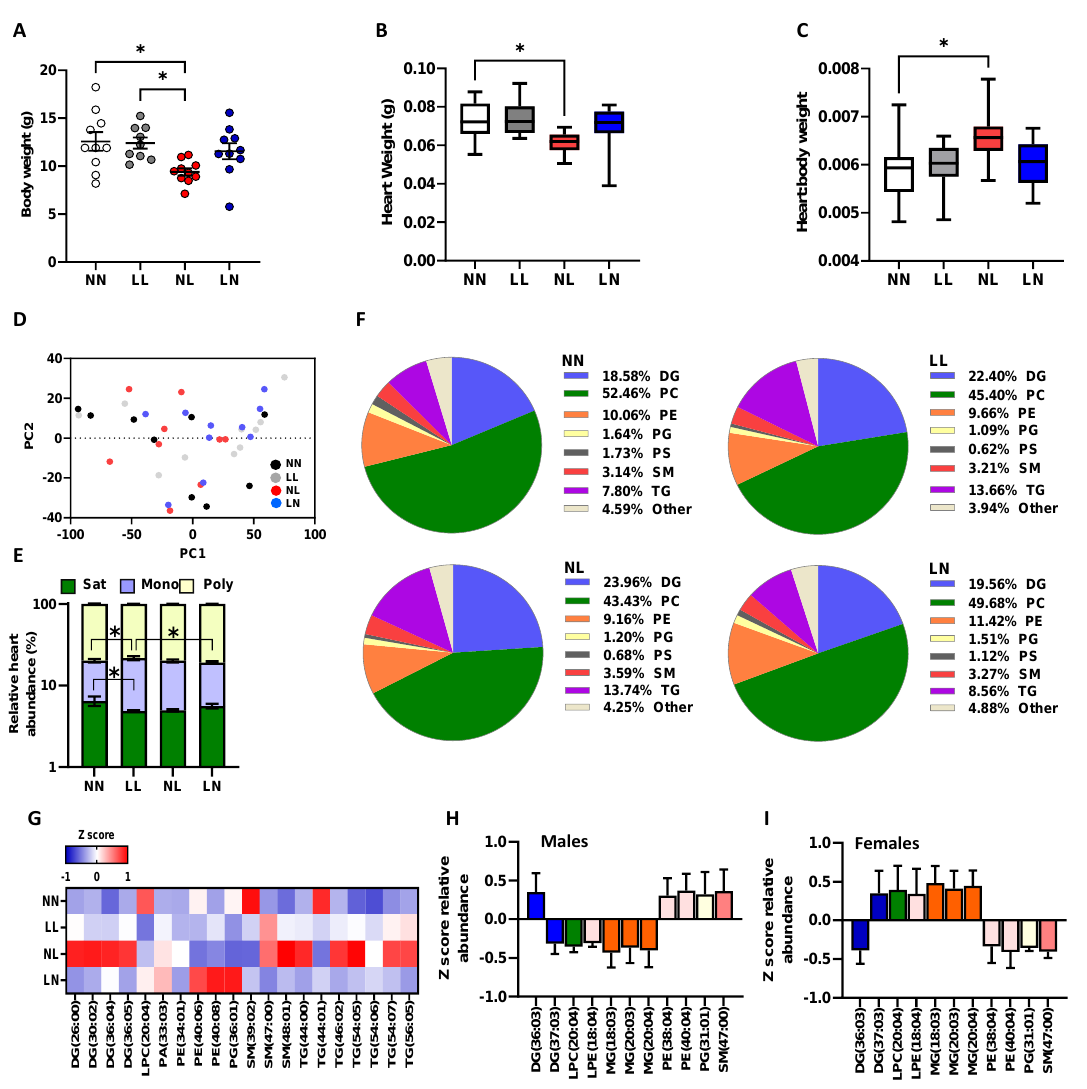
Figure 1. Impact of paternal diet on F1 neonatal offspring heart tissue lipid profiles: ( A ) the body weight, ( B ) heart weight and ( C ) heart:body weight ratio of NN (NPD sperm and LPD seminal plasma), LL (LPD sperm and LPD seminal plasma), NL (NPD sperm and LPD seminal plasma) and LN (LPD sperm and NPD seminal plasma) offspring at 3 weeks of age. ( D ) Principal component analysis (PCA) of differential lipids in NN, LL, NL and LN offspring hearts. ( E ) Relative levels of saturated, mono-unsaturated and poly-unsaturated lipids in NN, LL, NL and LN offspring hearts. ( F ) Relative levels of diglycerides (DG; water-loss product from fragmentation in source), phosphatidylcholines (PC), phosphatidylethanolamines (PE), phosphatidylglycerols (PG), phospatidylserines (PS), sphingomyelins (SM), triglycerides (TG) and other lipids in NN, LL, NL and LN offspring hearts. ( G ) Z scores of differential lipids between NN, LL, NL and LN offspring hearts. Differential lipid abundance in ( H ) male and ( I ) female offspring. N = 9–10 offspring (4–5 males and females) per treatment group, sampled from all litters generated. Data are expressed as mean ± SEM ( A – C ). * p < 0.05. Statistical differences were determined using a random effects regression analysis ( A , B ) or one-way ANOVA with Bonferroni post hoc correction ( E – H ).